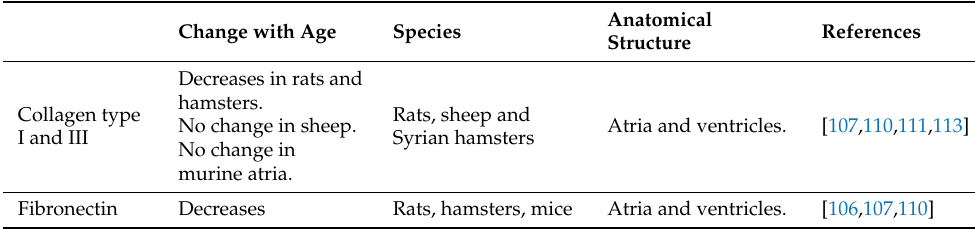
Table 3. Age-related changes in mRNA levels of collagen type I and III and fibronectin in the hearts of rats, Syrian hamsters, mice and